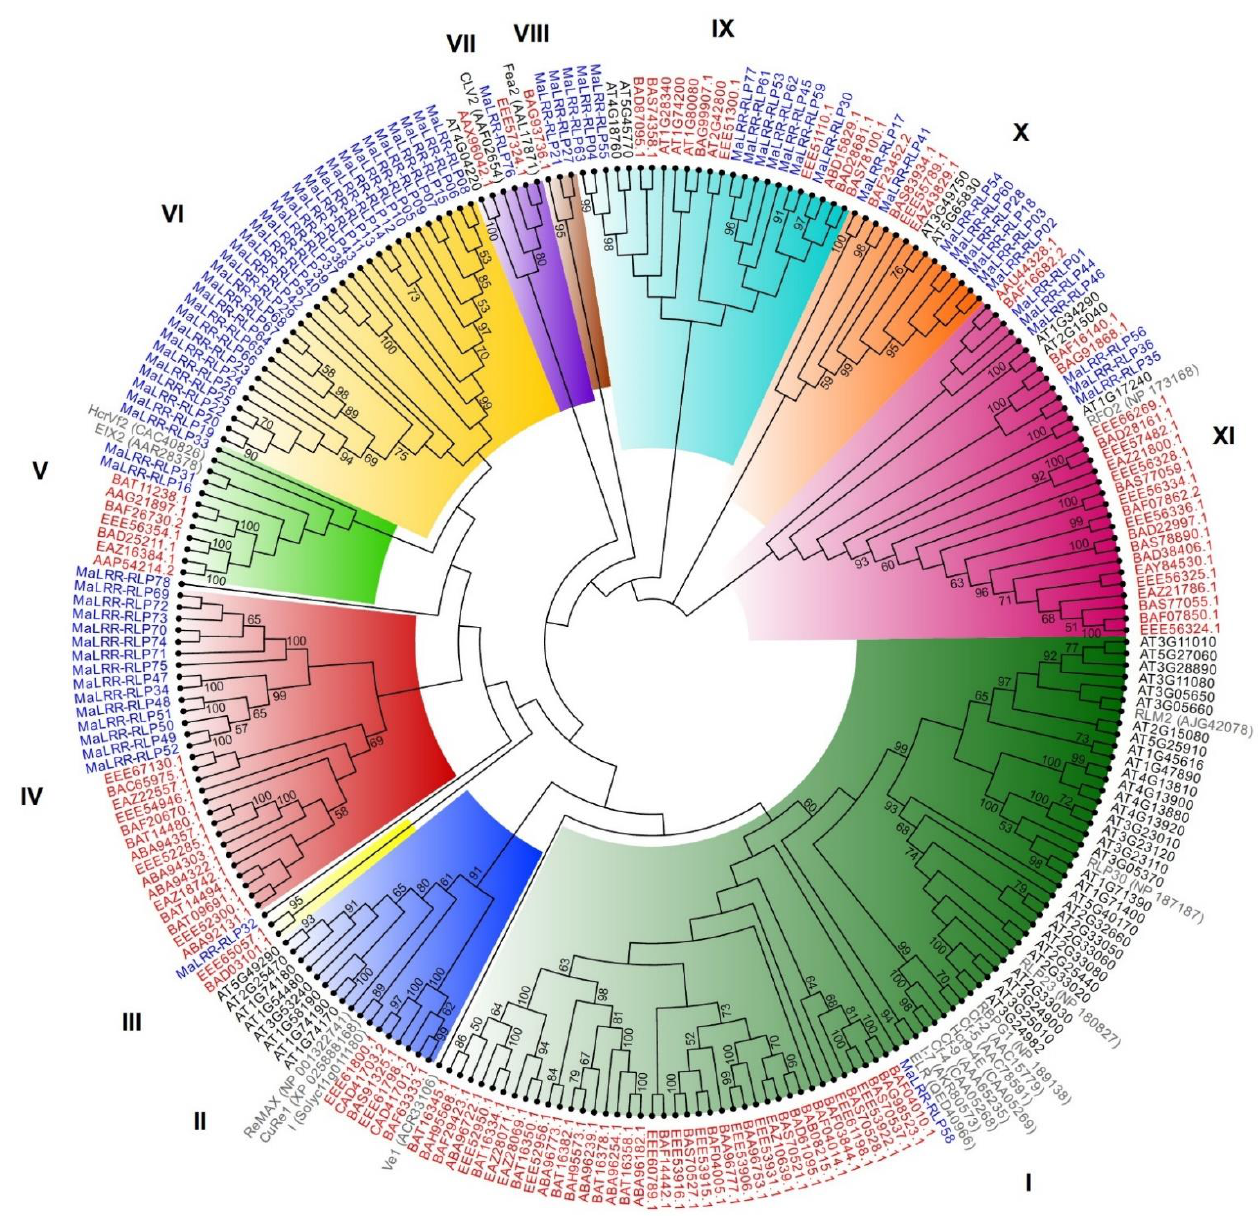
Figure 6. Maximum likelihood phylogenetic tree of banana, rice, and Arabidopsis LRR-RLP families. Banana, rice, and Arabidopsis LRR-RLP members are highlighted in blue, red, and black, respectively. The names and accession numbers (in parentheses) of LRR-RLPs involved in plant immunity or development are highlighted in gray or green, respectively. Numbers on the branches indicate the percentage of 100 bootstrap replications supporting the particular nodes, and only those ≥ 50% are shown. The C3-F region of LRR-RLP proteins was used for phylogenetic tree construction.